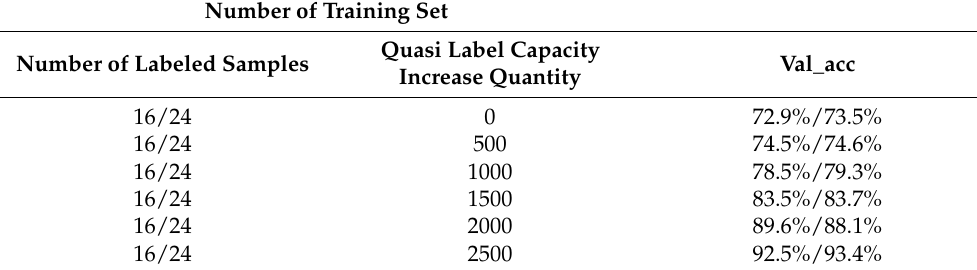
Table 3. Classification accuracy of vgg16 verification set under different capacity enhancement training sets.